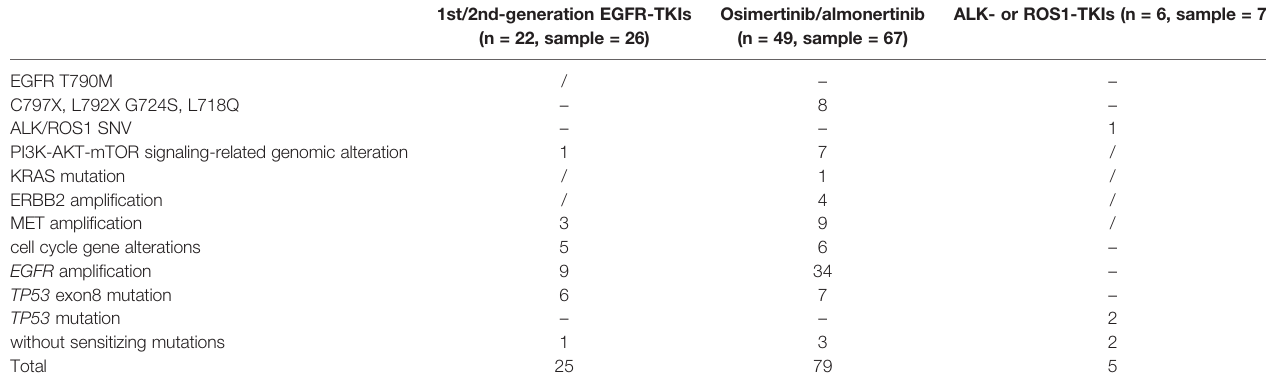
TABLE 2 | Known resistant mutations detected in CSF samples from NSCLC patients with CNS metastases who had previously received targeted